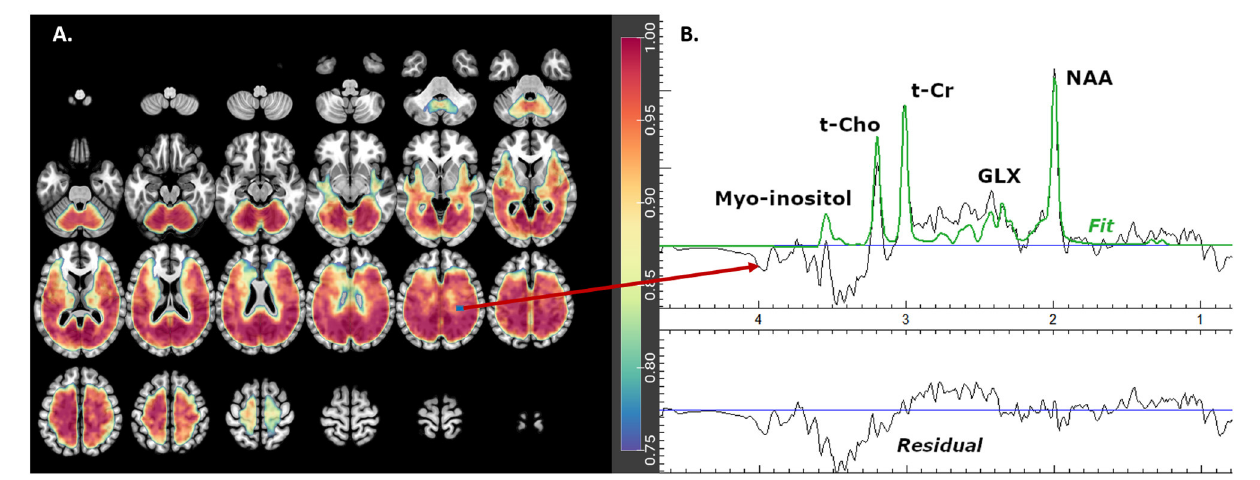
FIGURE 1 | Glx mask showing (A) axial brain slices with useful spectral coverage (color grading from blue- [0.75 coverage in each group] to red- [1.0 coverage in each group]) and (B) example of one fitted spectrum. Glx is glutamate plus glutamine, NAA is N-acetyl-aspartate compounds, t-Cho is choline, glycerol-phospho-choline, and phosphocholine and t-Cr is creatine plus